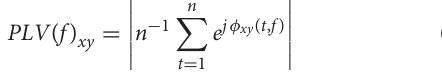
Figure 3 . The results of the study are reported for ten repetitions of the nested